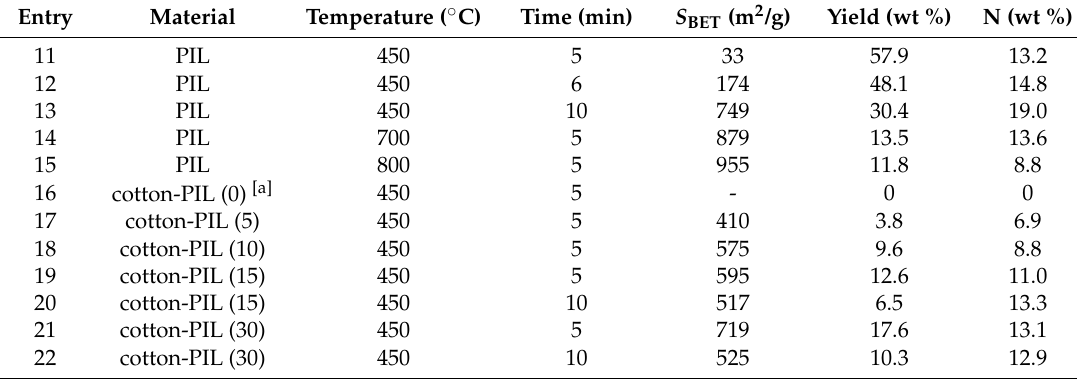
Table 2. Analysis results of carbon products obtained via pyrolysing poly(IL)s (PILs) (Entries 11–15) and cotton-PIL composites (Entries 16–22) in air at different holding times and temperatures.